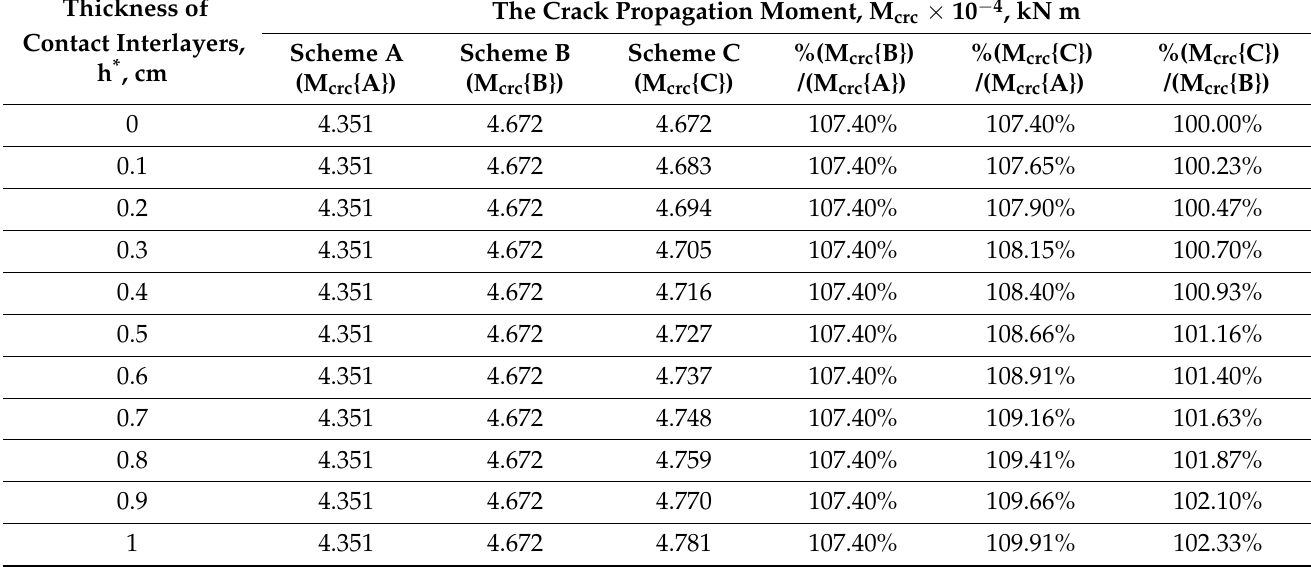
Table 7. The crack propagation moment M crc of multilayer